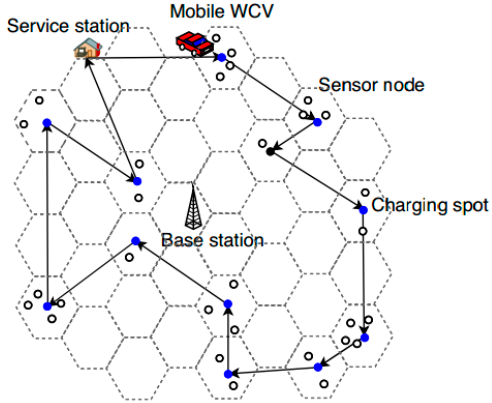
Figure 2. Wireless sensor network with a WCV using cell centers to find stay points on the traveling